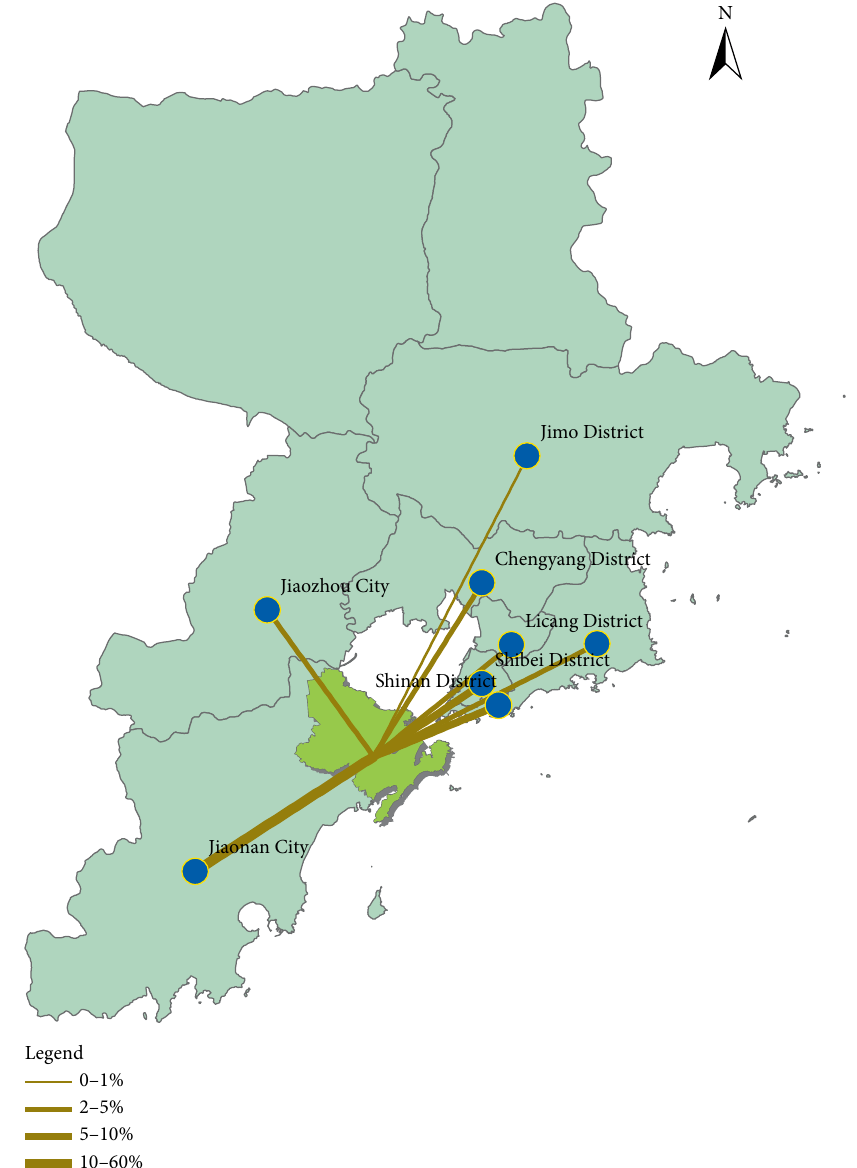
Figure 6: The internal-external linkage of west